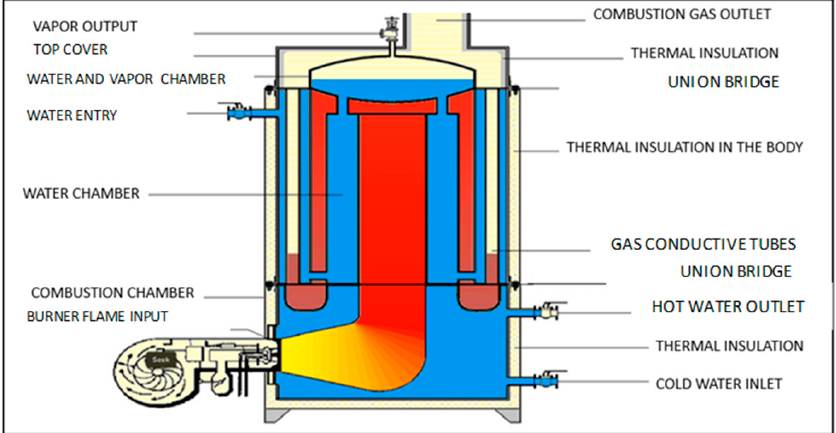
Figure 14. The combustion gases have completed their first run and are starting their third.